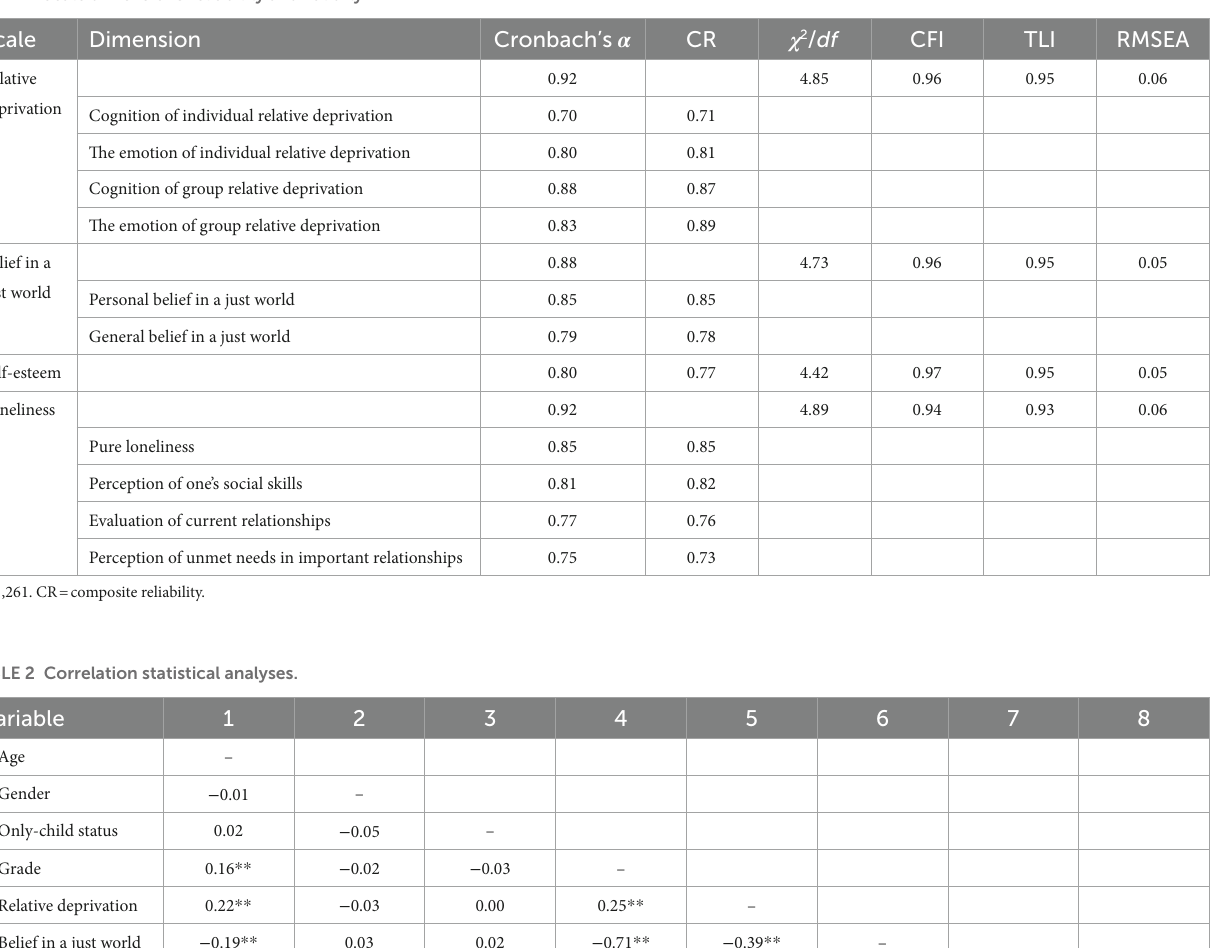
TABLE 1 Scale dimensions reliability and validity.